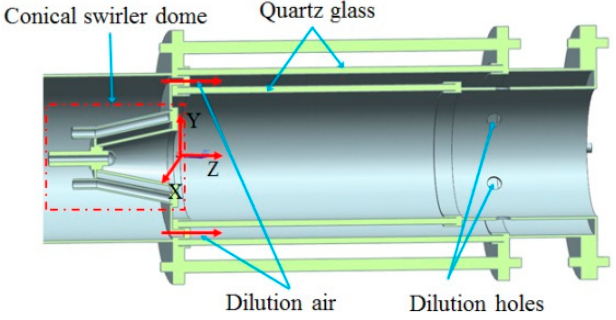
Figure 4. CAD view of the assembly of the conical swirler and model combustor.